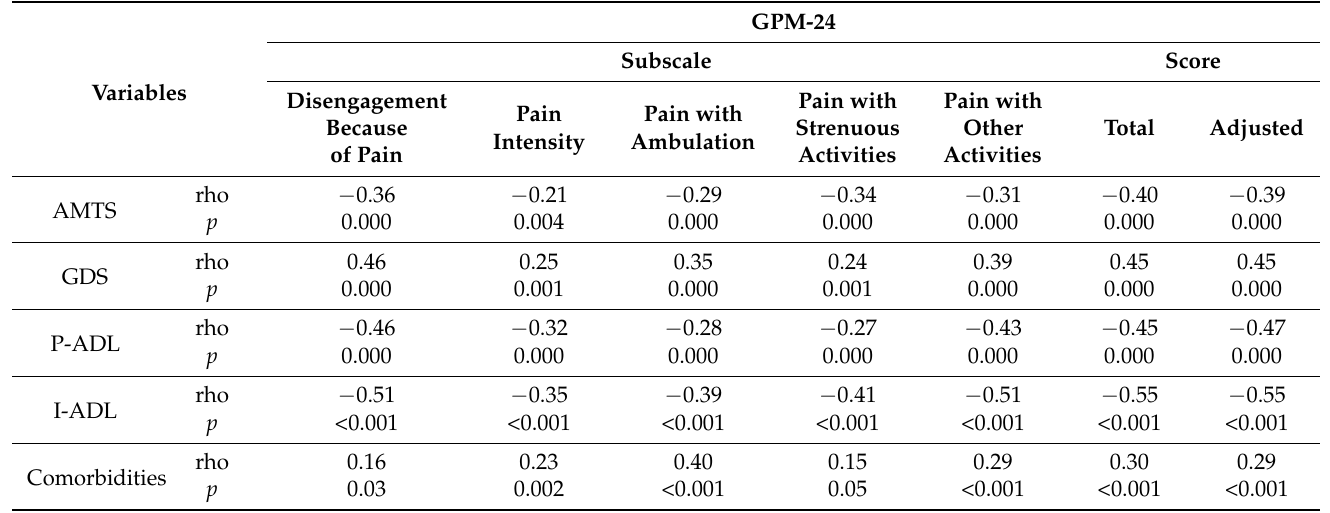
Table 4. Spearman’s Rho correlation of variables determining the functional capacity of people with chronic